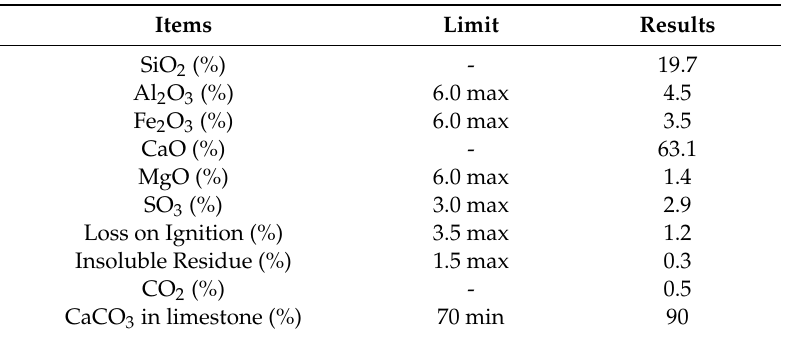
Table 2. Portland cement chemical compositions.